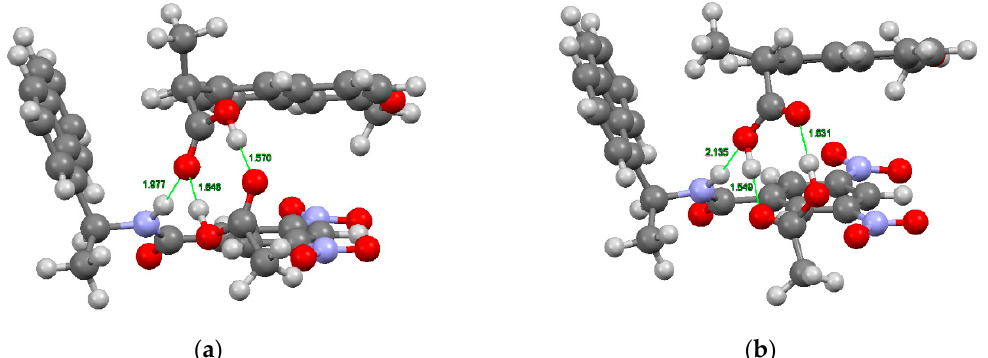
Figure 11. The lowest energy structures of ( S )- B ( a ) and ( R )- B ( b ). Selected bond lengths are indicated in Å. B3LYP/def2-TZVPP//M06-2X/def2-TZVPP (COSMO, ε = 2.78).